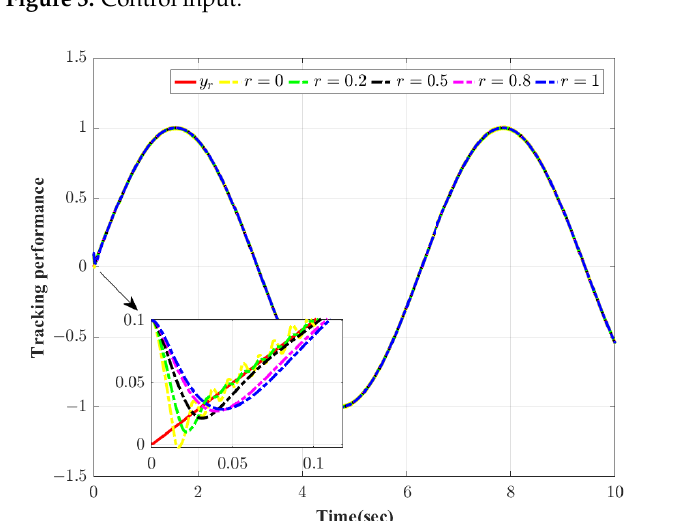
Figure 3. Control input.